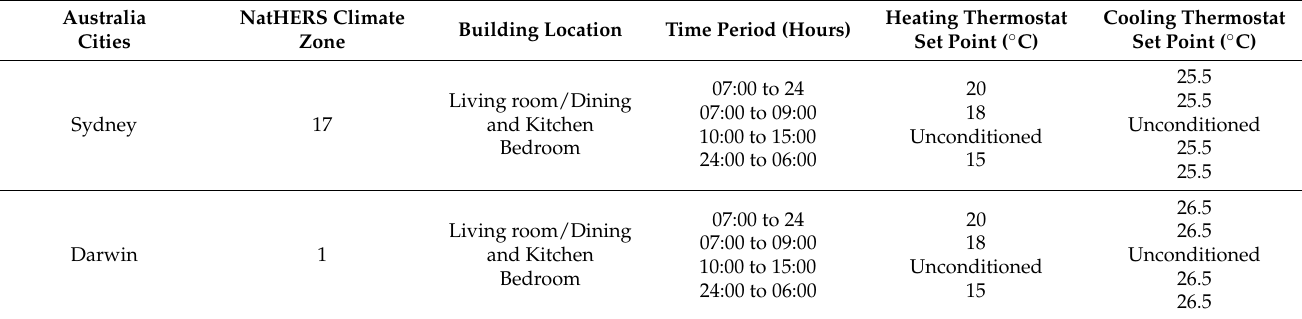
Table 5. Australian NatHERS heating and cooling thermostat set point temperatures for two Aus- tralian capital